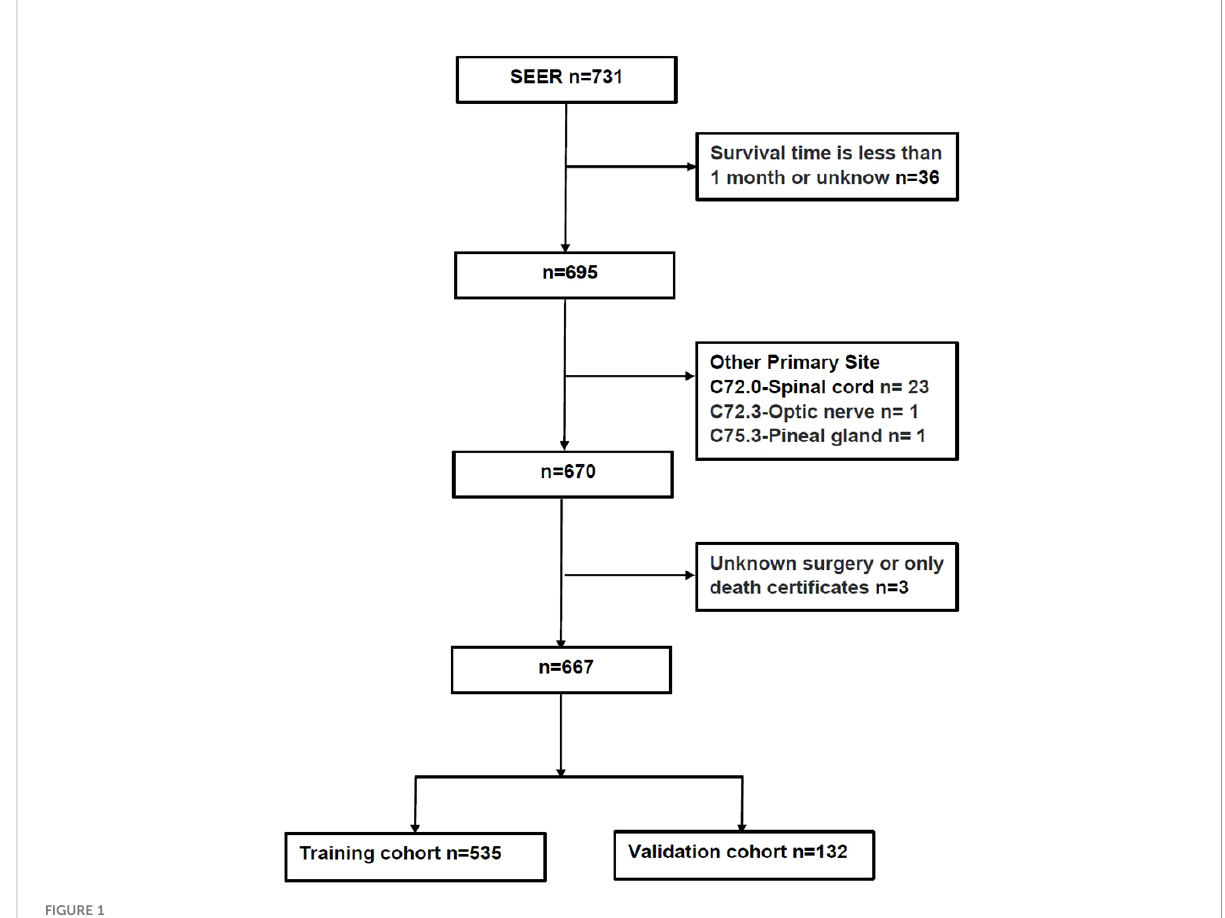
FIGURE 1 Method of retrieving data from the data